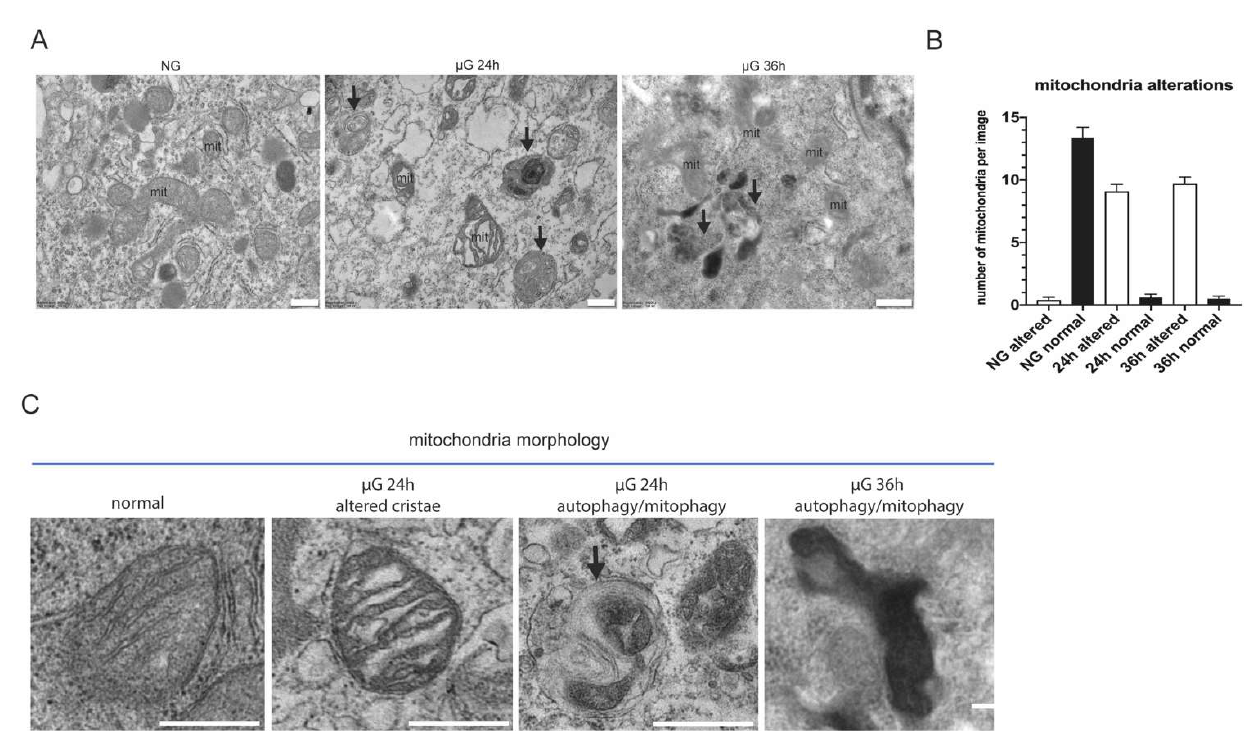
Figure 3. Ultrastructural analysis of mitochondria morphology under µG. Representative micrographs of A549 cells subjected at normal versus µG for 24 and 36 h. ( A ) Normal gravity mitochondria (mit) display normal cristae and electron- density. Abundant endoplasmic reticulum (ER) cisternae are visible surrounding them. Altered mitochondria (mit) with abnormal cristae and increased electron-density are observed in µG-treated cells. ER cisternae appear dilated. Several autophagic/auto lysosomal vacuoles are evident at both 24 and 36 h (black arrows), and are rarely observed in ground cells. Scale bars: 500 nm. ( B ) Histogram showing the number of altered mitochondria per micrograph in each experimental condition (mean+/−SEM). ( C ) High magnification details of mitochondria morphology alterations in µG compared to mitochondria in normal gravity. Note the alterations of cristae, the increased electron-density, and the presence of an autophagic vacuole containing a putative damaged mitochondrion (black arrow). Scale bars: 500 nm. Table 2. microRNAs down- and up-regulated in A549 cells selected after enrichment procedures.